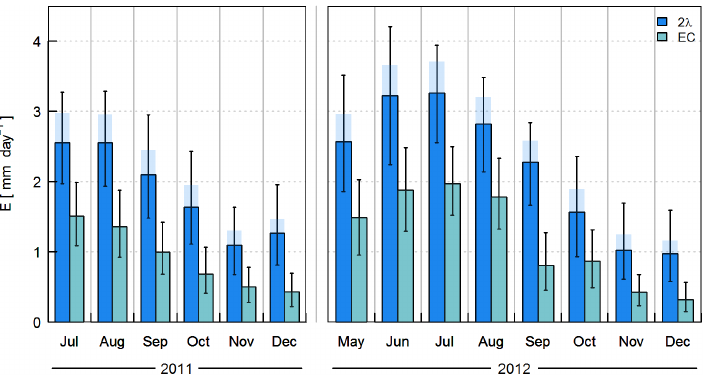
Figure 7. Average daily evapotranspiration by month: bars represent the sum over the median daily cycle of evapotranspiration for each month; error bars indicate the upper and lower quartiles; shading indicates the impact of using the De Bruin et al. (1993) similarity function.